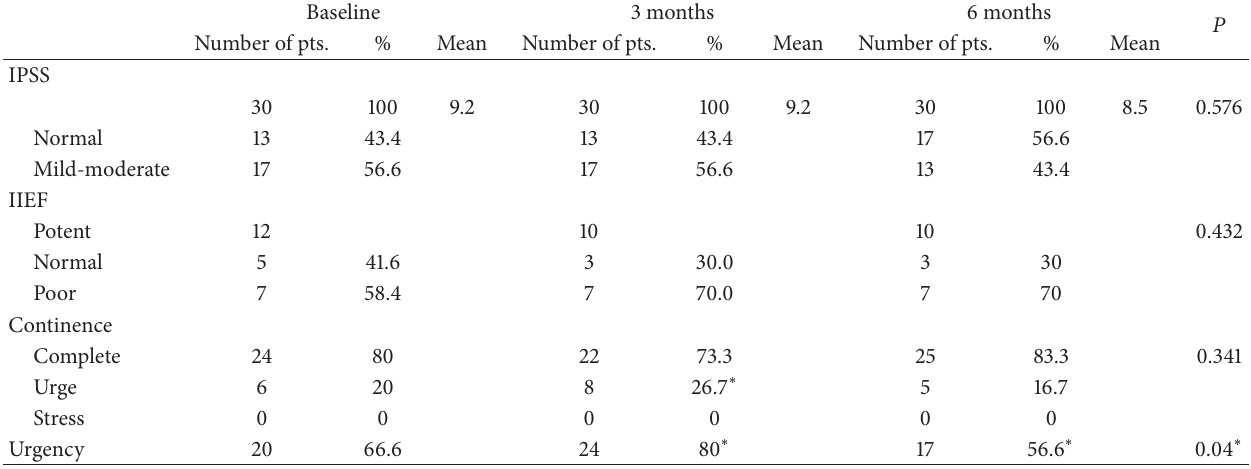
Table 1: Subjective data relative to International Prostate Symptoms Score IPSS, International Index Erectile Function 5 IIEF, continence status, and urgency.